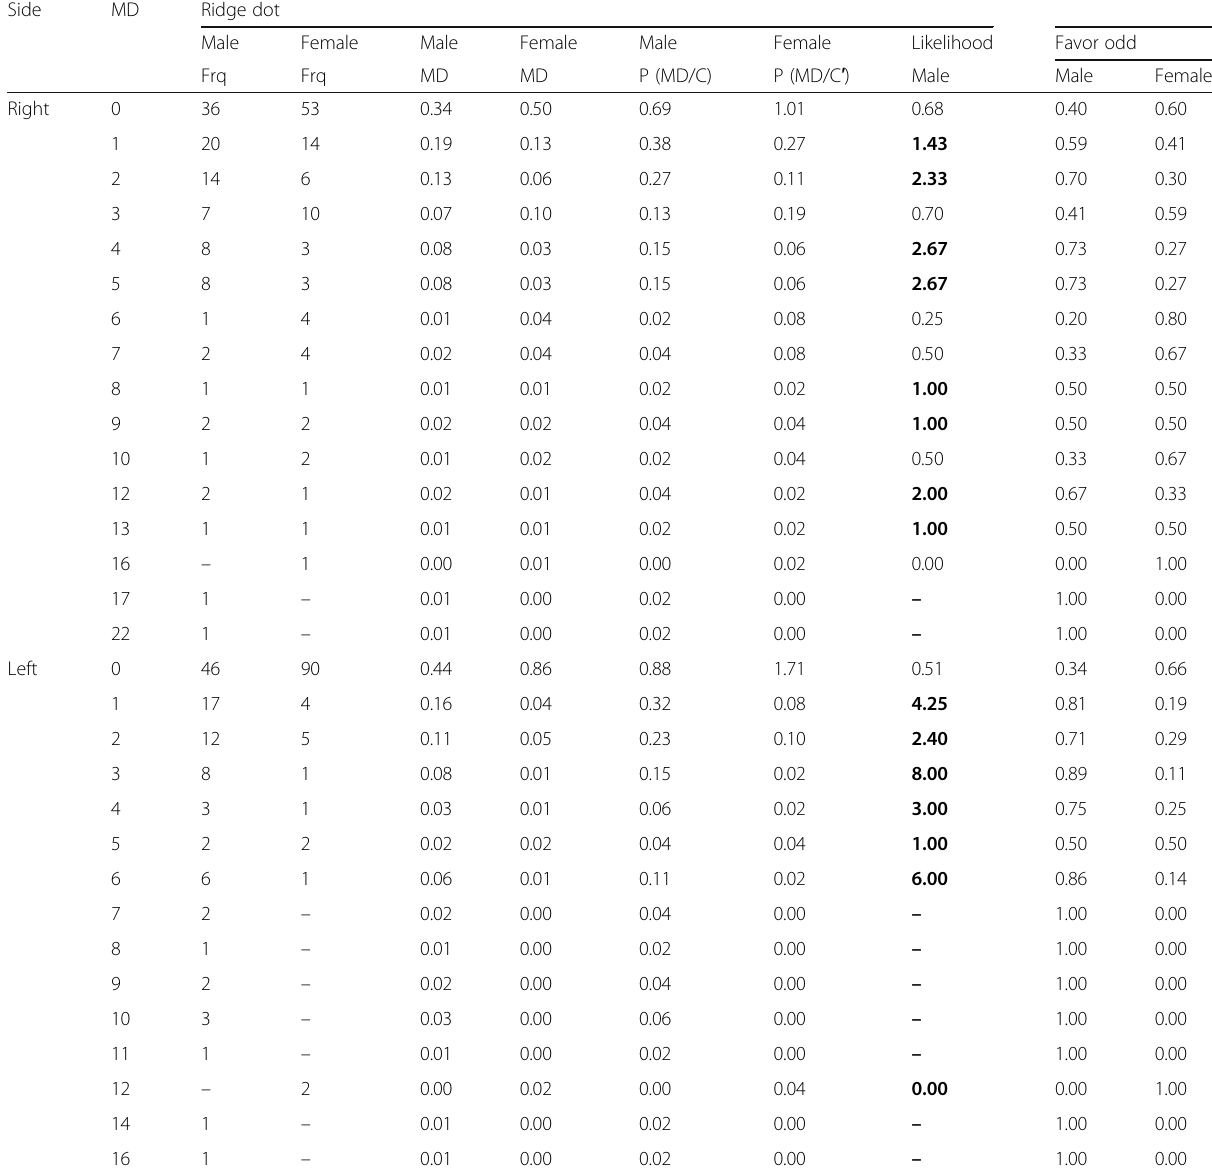
Table 5 Frequency, likelihood ratio and favor odd of different ridge dot density of right and left thumbprints Side MD Ridge dot